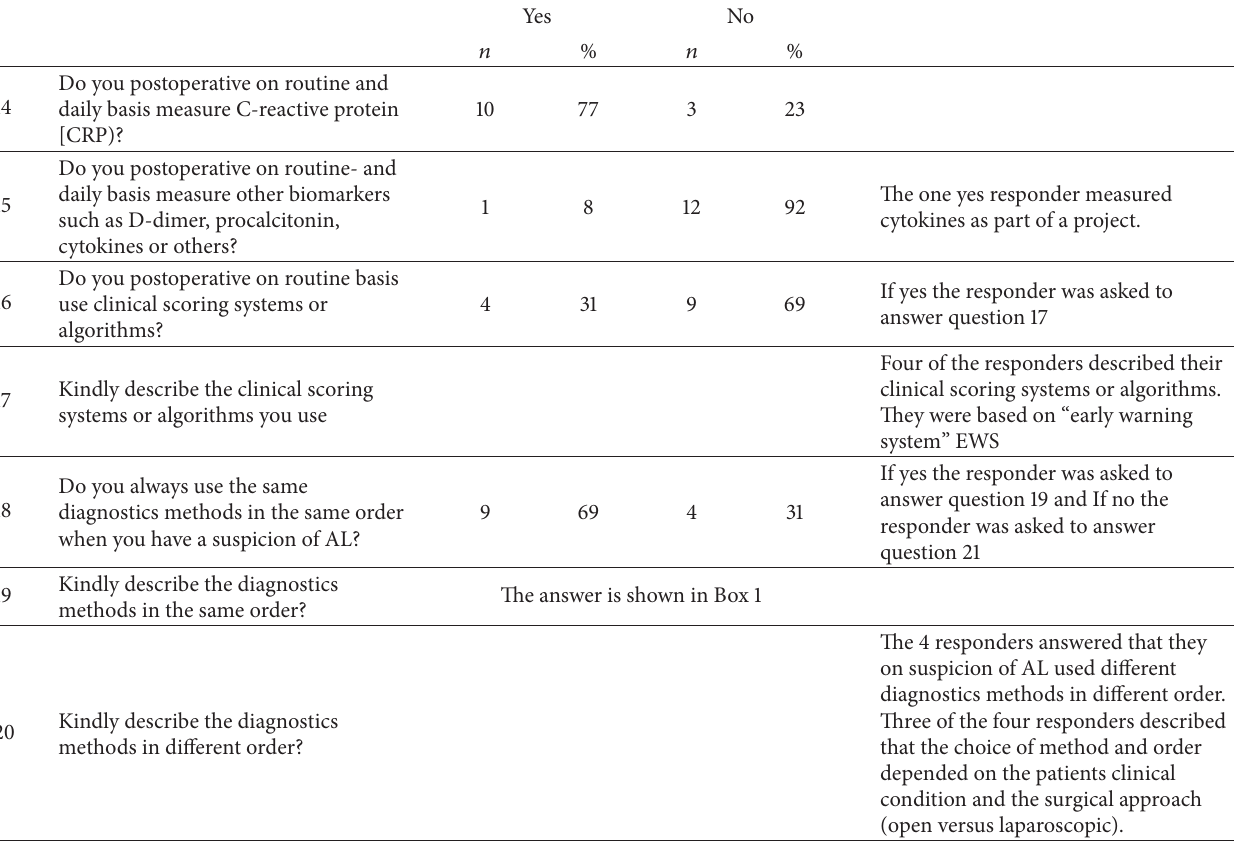
Table 2: Questions about postoperatively used routine measurements or